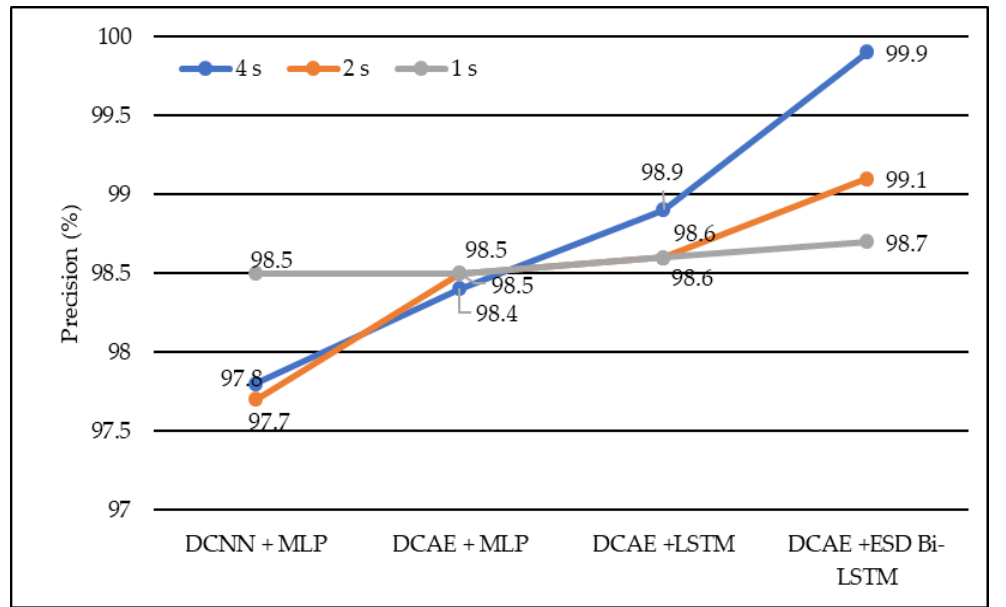
Figure 6. Average precision of different models using different EEG segment lengths.